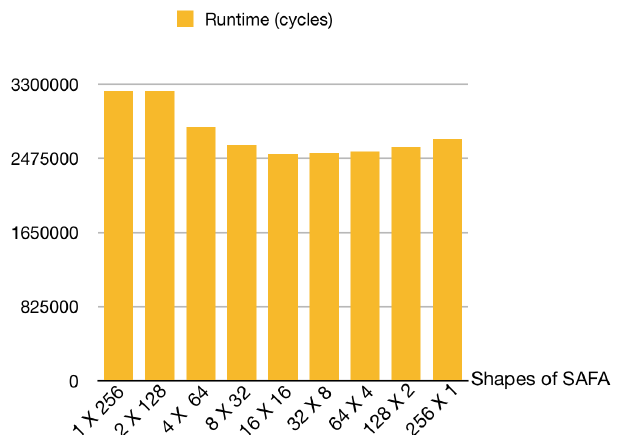
Figure 10. Runtime of SAFA in different shapes. Note that a square array (16 × 16) for SAFA achieves the shortest